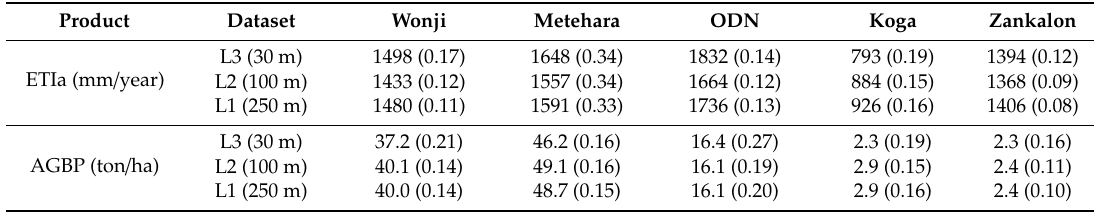
variation (CV) reported in